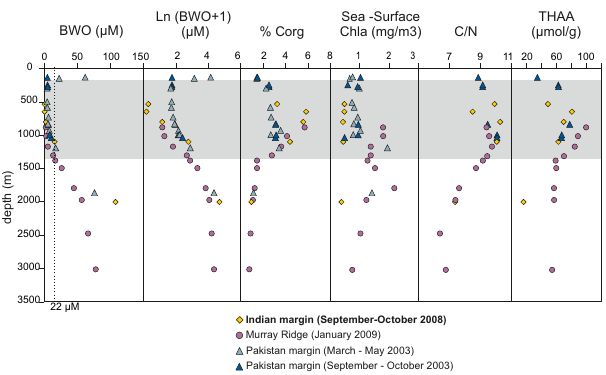
Figure 5. Regional comparison of the environmental parameters on the Indian and Pakistan margins and the Murray Ridge. The C org content, C/N, THAA concentration data are from Hunter et al. (2012) and Cowie et al. (2014) for the Indian margin; from Vandewiele et al. (2009) for the Pakistan margin; from Koho et al. (2013) for the Murray Ridge. Because some values were <1, the BWO was expressed using the natural logarithm + 1 (Ln(BWO + 1)). The dark-grey shading corresponds to the